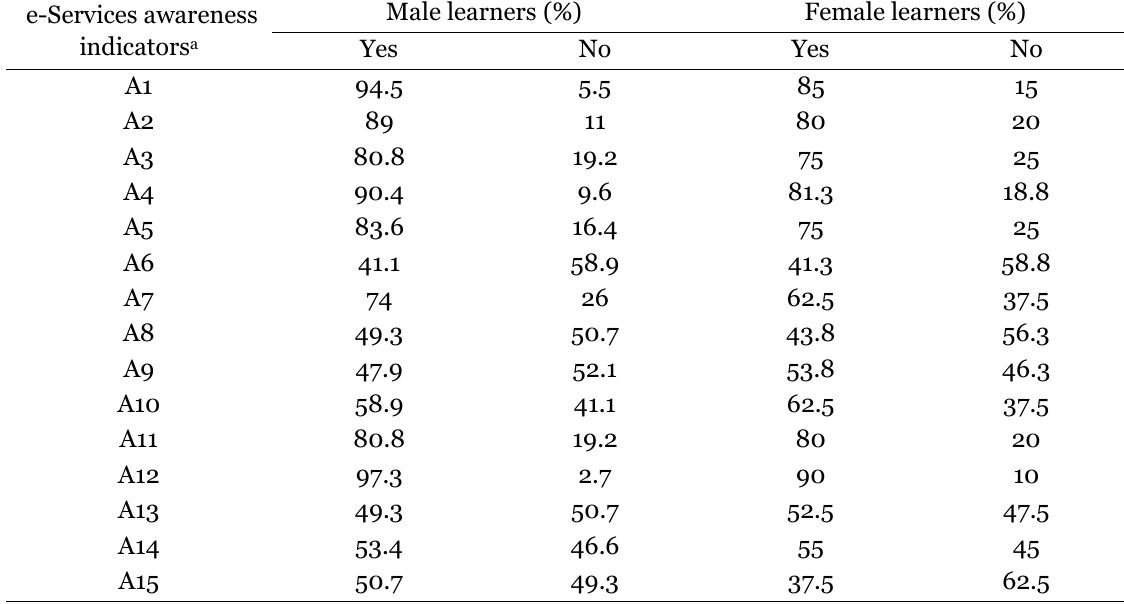
Learners’ Awareness of the University's e-Services by Gender e-Services awareness indicators